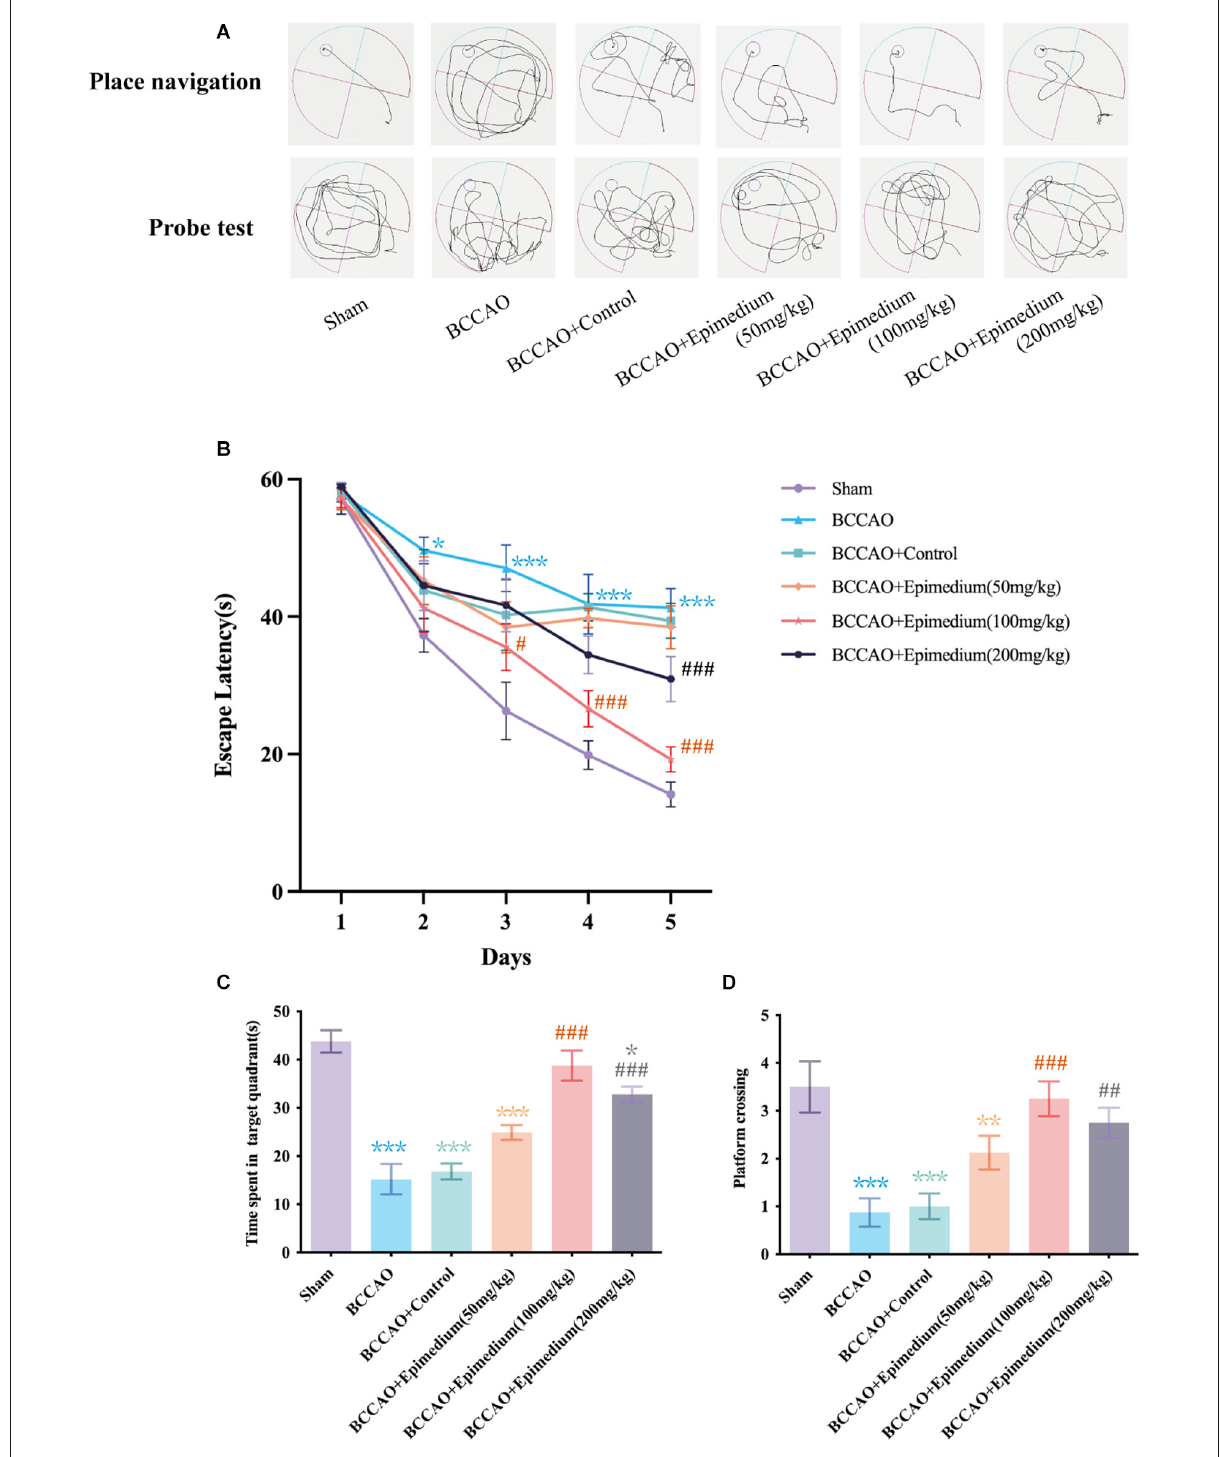
FIGURE10 Epimedium treatment alleviated VaD induced cognitive impairment. (A) The present track route of place navigation and probe test. (B) The escape latency in each group ( n = 8). (C) Time spent in the target quadrant in the probe trial. (D) The number of platform crossing in the probe trial. Values are expressed as mean ± SEM ( n = 8). *** P < 0.001, ** P < 0.01 and * P < 0.05 vs. the sham group; ### P < 0.001, ## P < 0.01, and # P < 0.05 vs. the BCCAO